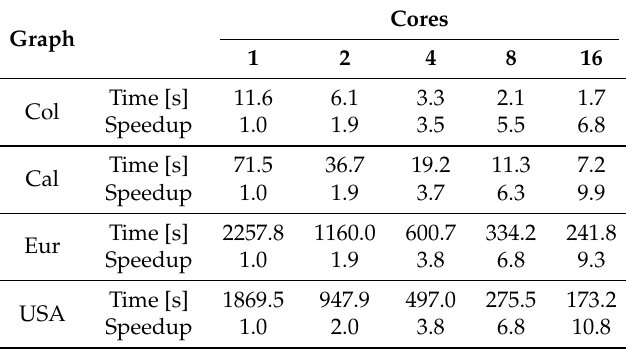
Table 3. Running times in seconds of IFC8, using up to 16 cores of the Skylake CPU.